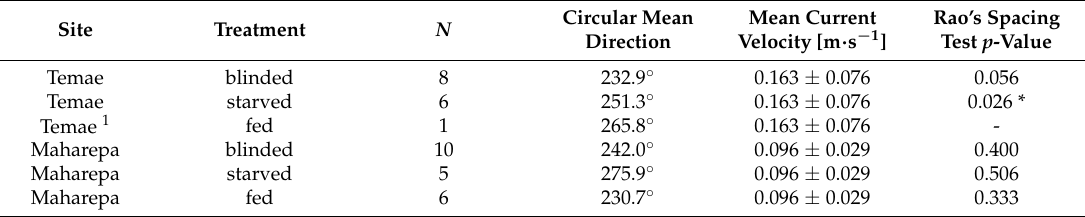
Table 1. Mean movement direction of Acanthaster cf. solaris after one hour and test for a preferred direction (Rao’s spacing test) at two sites with respective water current strengths. Note that the circular mean direction is not very meaningful when there is no preferred direction in the seastars’ movement (when Rao’s spacing test is not significant). * Refers to significant test p <